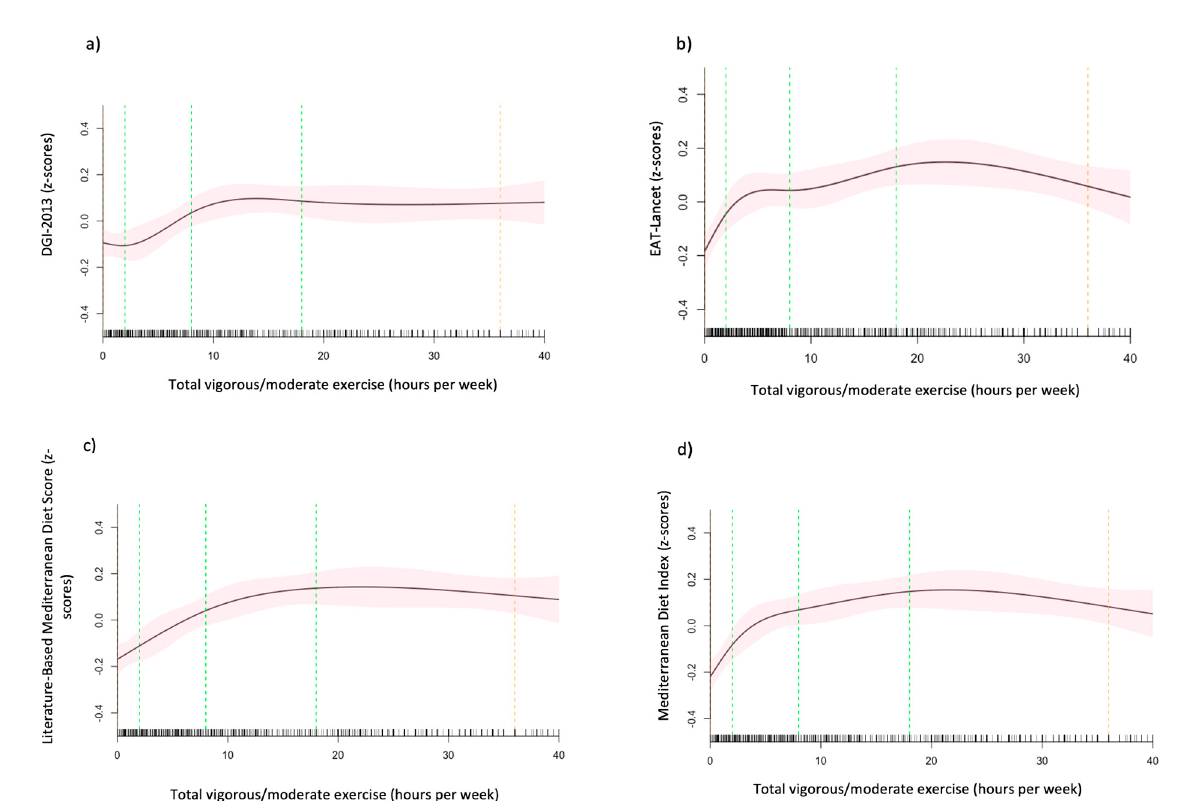
EAT-Lancet is steeper than the Lit-MedDiet. All the curves are a similar rounded shape, approximately 10 h per week (Figure 4a).